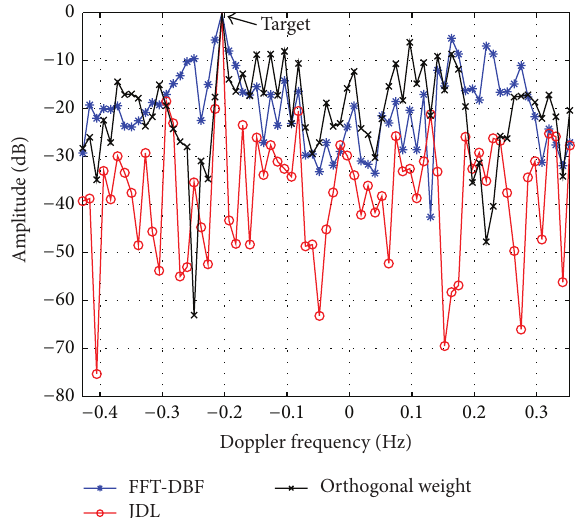
Figure 10: Compared Doppler results (real sea clutter, target azimuth 95 ∘ ).